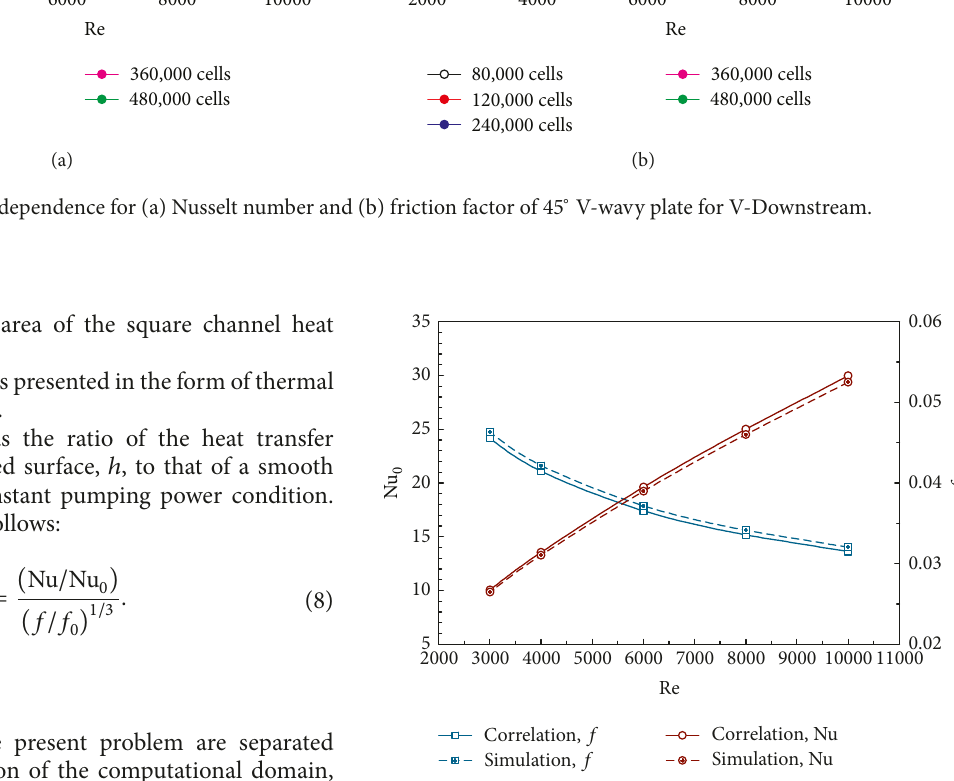
Figure 3: Verification of the smooth channel on Nusselt number and friction